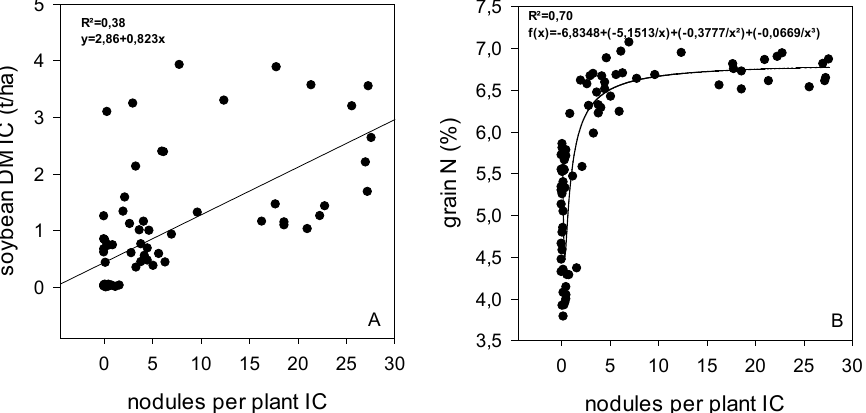
Figure 2. Regression of number of nodules per IC soybean plant on IC soybean DM (t ha −1 ) ( A ) and number of nodules per IC soybean plant on grain N of MC soybean ( B ); IC = intercrop; MC = main crop; DM = dry matter.